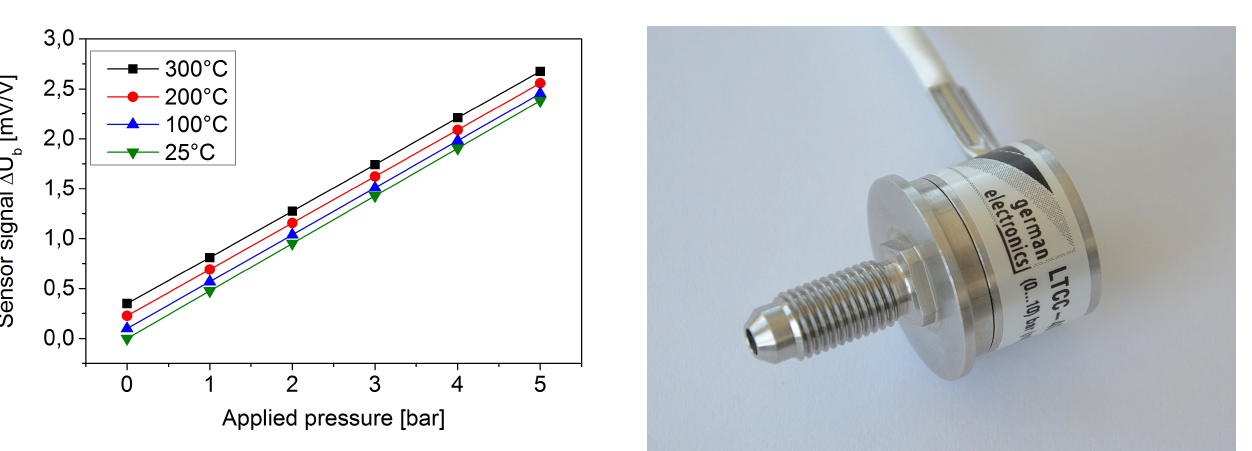
Figure 14. Temperature-dependent pressure-signal characteristics of a completely packaged LTCC sensor. Figure 15. Completely assembled sensor with steel connect screw and welded steel housing with